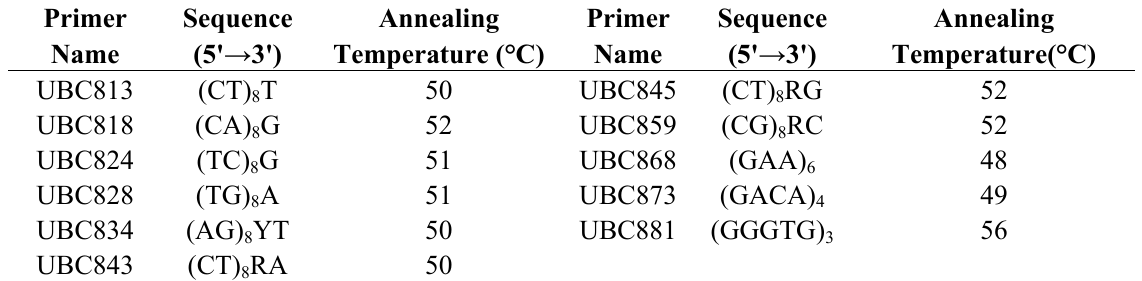
Table 6. ISSR primers used in the present